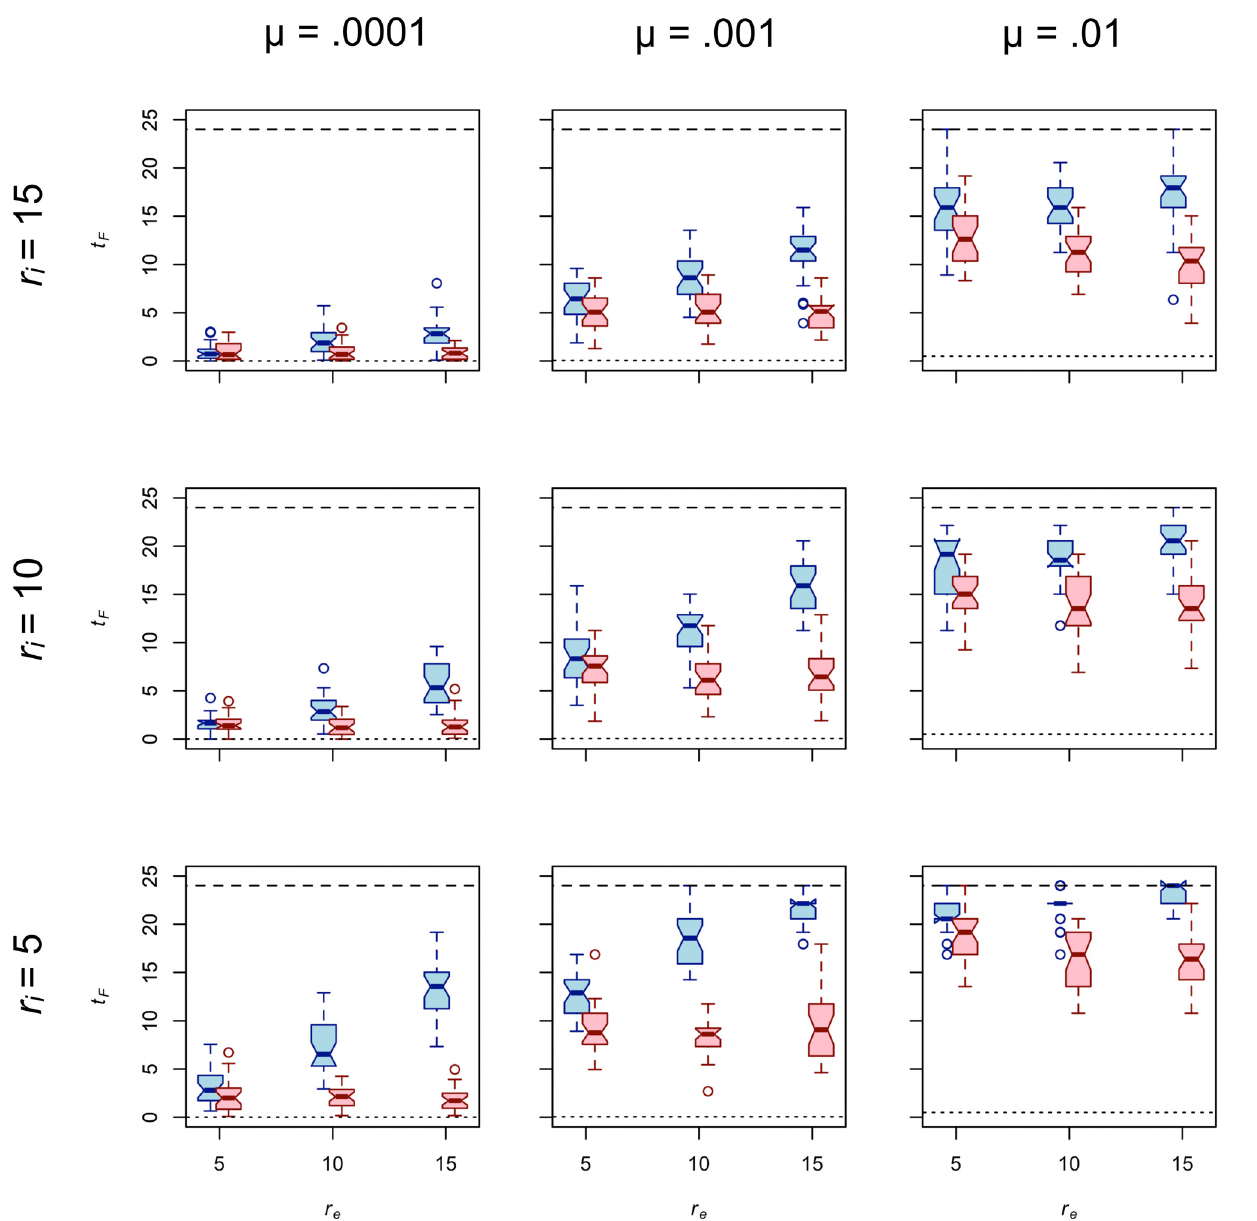
Fig 3. The effect of r e on the diversity of trait A (blue) and trait B (red) for d = 0.75. Each boxplot represents 30 unique simulation runs. Interaction radius increases from the bottom row to the top row. Copy error rate increases from the left column to the right column. The dotted line in each panel provides the expected value of t F in a standard Wright-Fisher population. The dashed line in each panel provides the expected value of t F under extreme uniparental vertical cultural